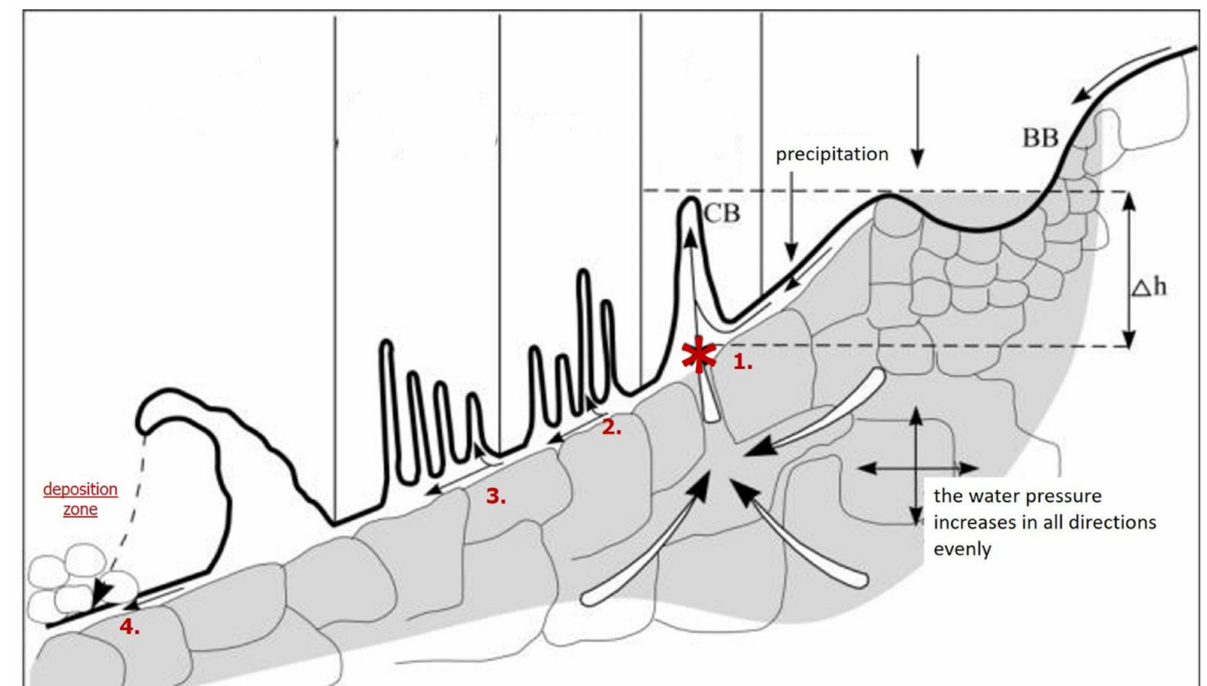
Figure 21. Computer simulation of trigger water discharge/mudflow process—soliton nonlinear hydrodynamic model. The multiple solitonic variation regime propagation is shown and developed from a single soliton from the very beginning due to pressure variation over the induced stable channels in the void cavity system (the discharge/mudflow exit on the surface is indicated by the red star, 1). BB–collecting funnel; CB–mudflow soliton wave; ∆ h–hydrostatic thrust/pressure